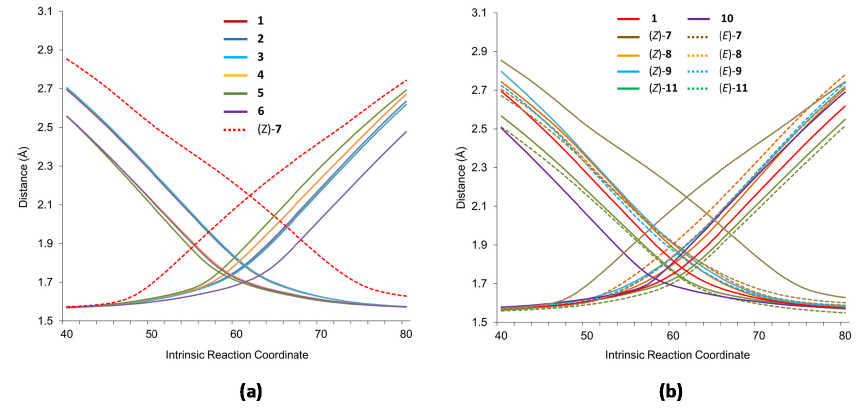
Figure 2. Evolution of breaking/forming bonds along the reaction coordinate (20 points before and after the TSs, P61 are given) of the 2-aza-Cope rearrangement of γ -alkenyl nitrones 1 – 6 (and ( Z )- 7 ) ( a ), and 7 – 11 and 1 ( b ). Ascending and descending trajectories correspond to breaking (C3–C4) and forming (C1–C6) bonds,